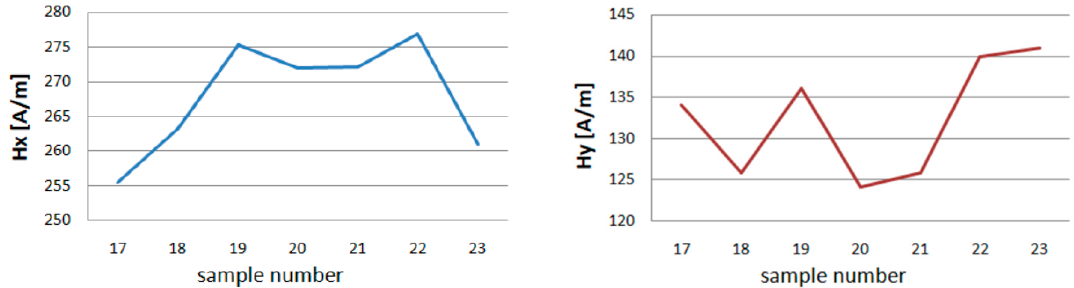
Figure 12. Minimum of tangential component Hx and Hy for experiment E.